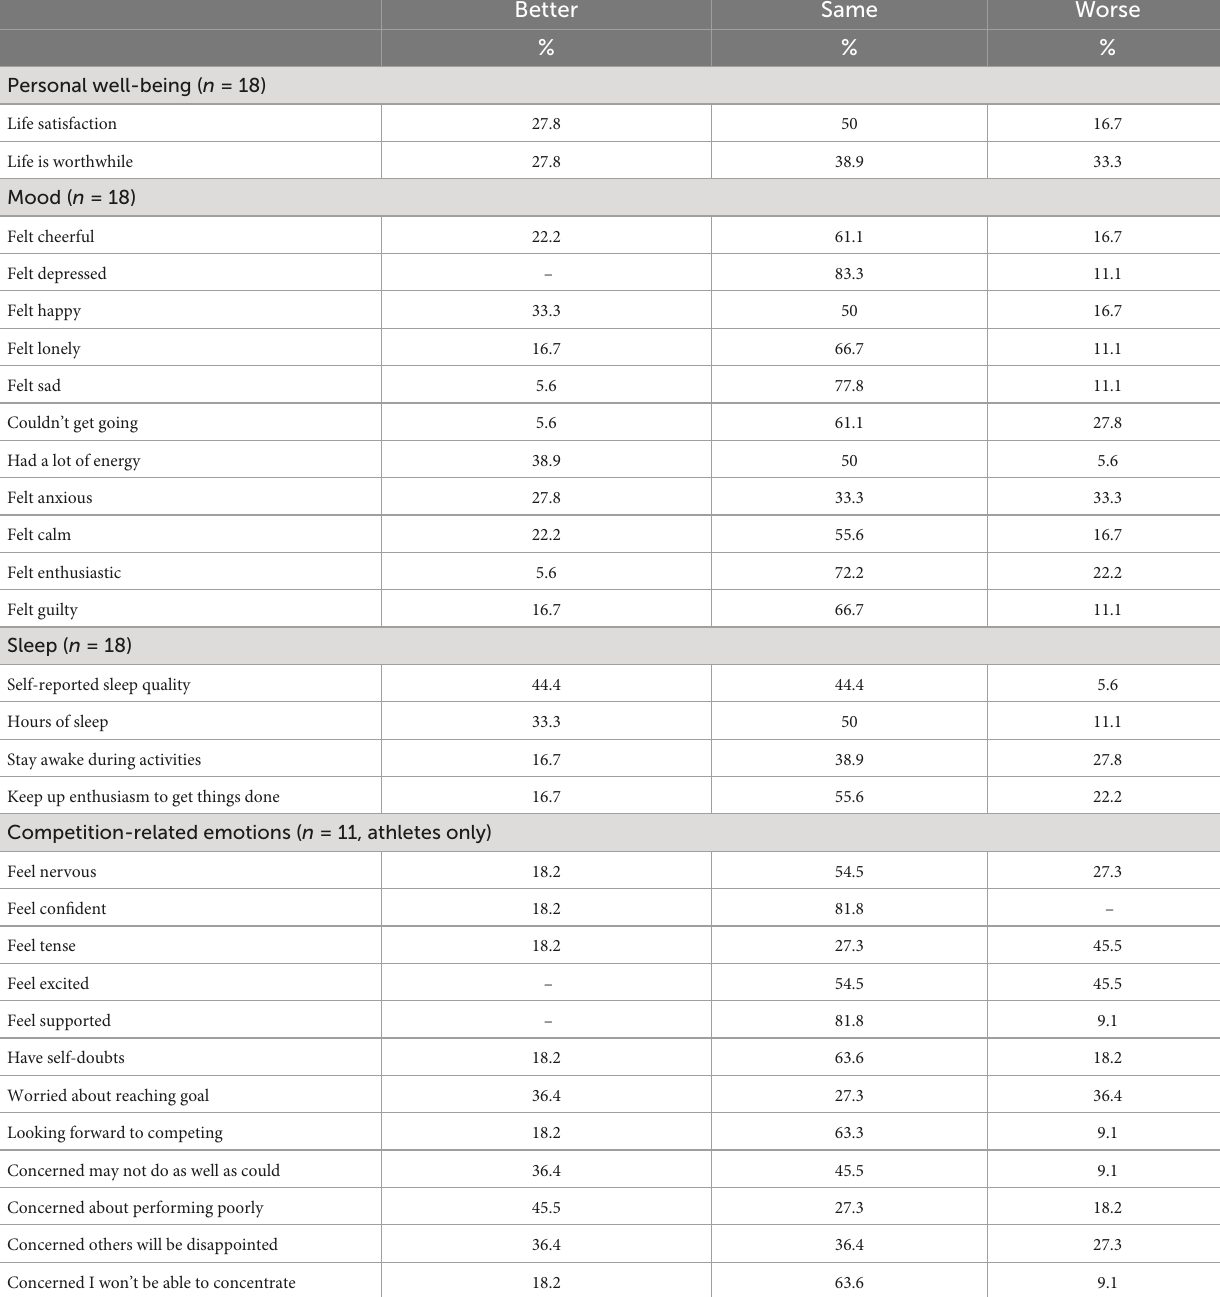
TABLE 2 Categorical change in mood, sleep, and competition-related emotions. Better Same Worse % %